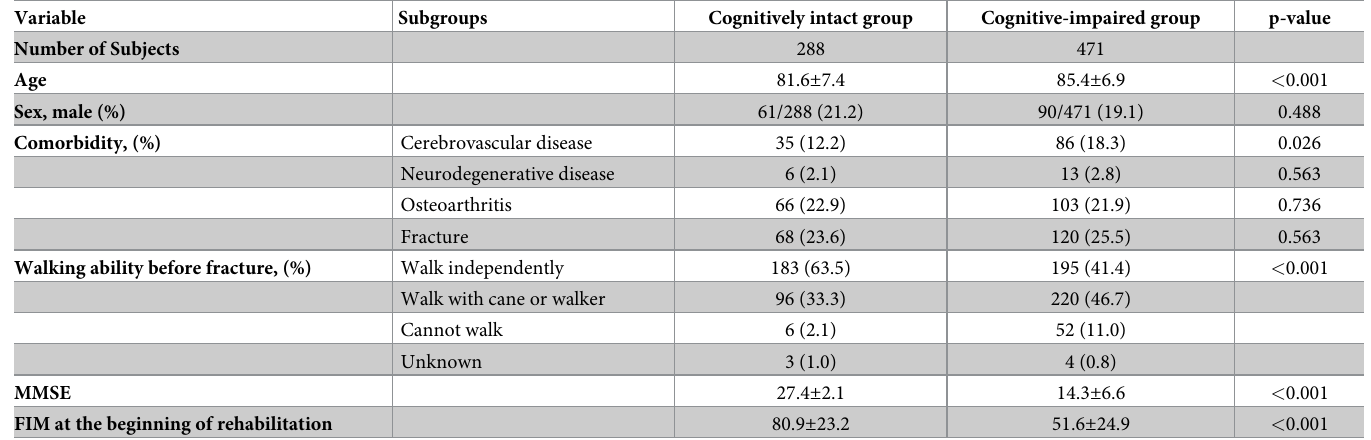
Table 1. Characteristics of older individuals.